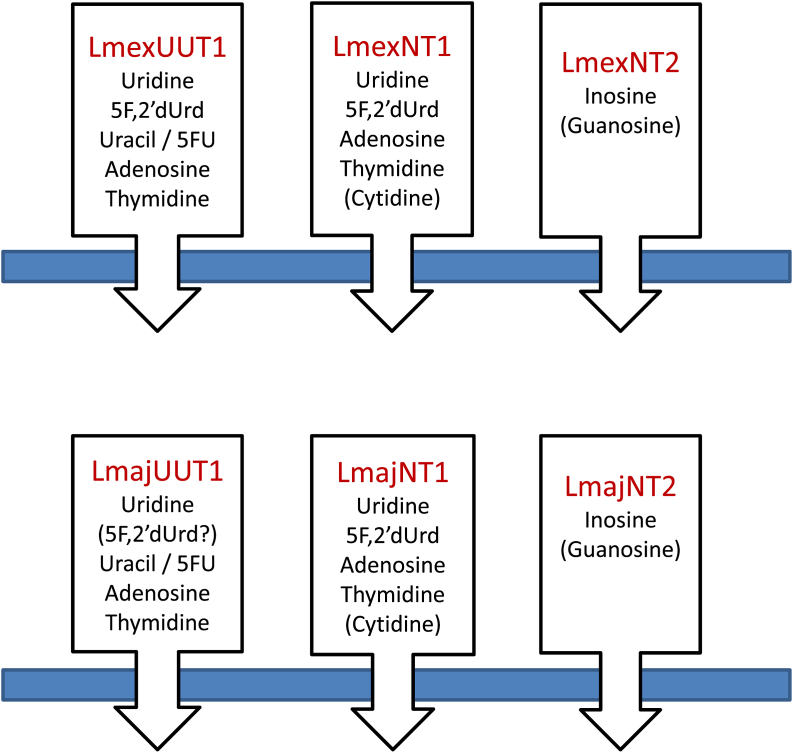
Schematic model of pyrimidine transport activities in L. mexicana (top panel) and L. major (lower panel). The blue bars represent the parasite plasma membranes, with the arrow heads pointing to intracellular space. Each box-arrow represents a transport activity, identified in bold red font, with substrates listed underneath; expected substrates that were not tested in this study or of low affinity are listed in brackets.